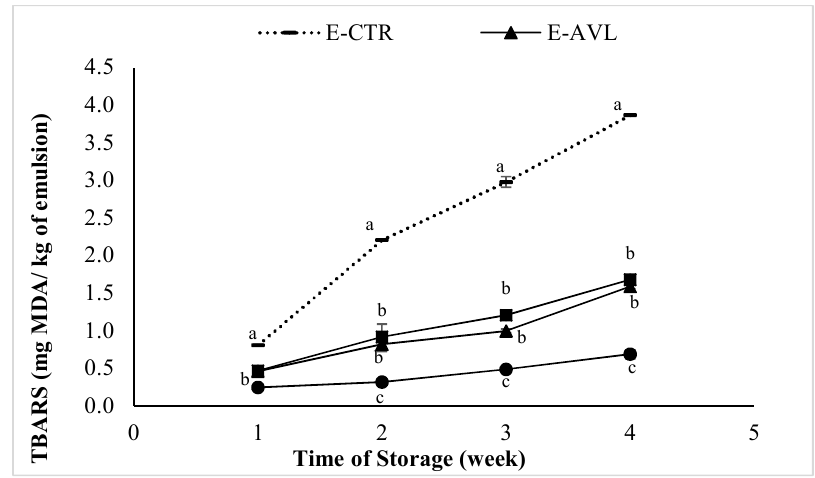
Figure 3. Changes in Thiobarbituric Acid Reactive Substance (TBARS) values of the emulsion containing A. vulneraria leaf and flower extracts during storage. E-CTR (Control emulsion sample), E-AVL ( A. vulneraria leaf emulsion sample), E-GA (Galic acid emulsion sample), E-AVF ( A. vulneraria flower emulsion sample). Error bars represent standard deviation ( n = 3) and different letters in the same day indicate significant difference between samples at p < 0.05.